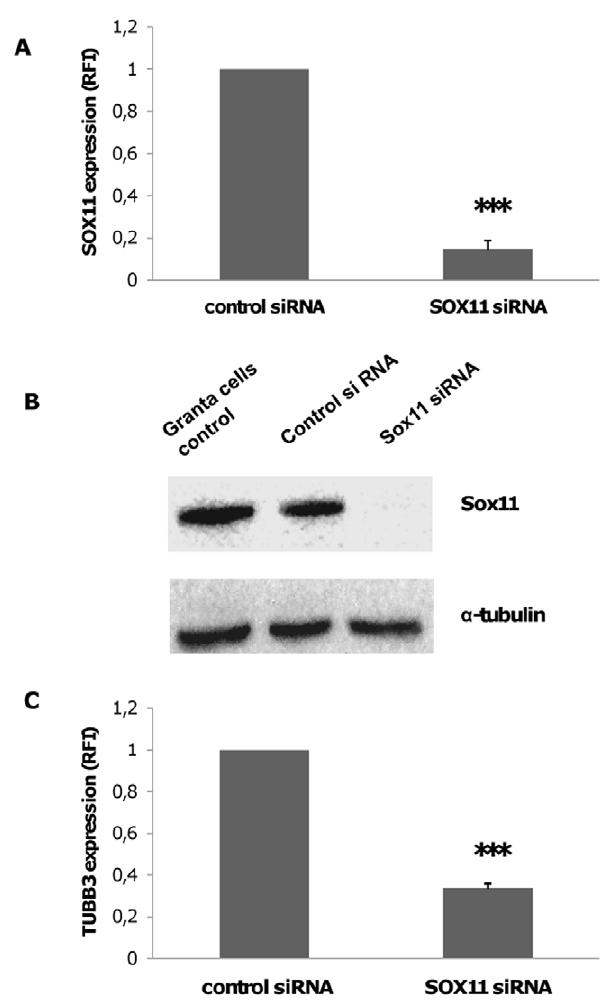
Figure 2. SOX11 silencing significantly reduces TUBB3 expres- sion in the MCL cell line Granta 519. (A) Expression of SOX11 was evaluated after transfection with either 100 pmol SOX11 siRNA or control siRNA. The SOX11 mRNA level was measured by quantitative RT-PCR 20 hours after electroporation. Error bars show standard deviation of 4 independent experiments, ***p , 0.001. (B) Western blots show downreg- ulation of SOX11 protein in Granta 519 after SOX11 siRNA knockdown but not in cells treated with control siRNA or in untransfected cells. (C) Depletion of SOX11 protein significantly reduces TUBB3 expression. Granta 519cellsweretransfectedwithSOX11siRNA andTUBB3expression was investigated by quantitative RT-PCR after 20 hours. ***P , 0.001.